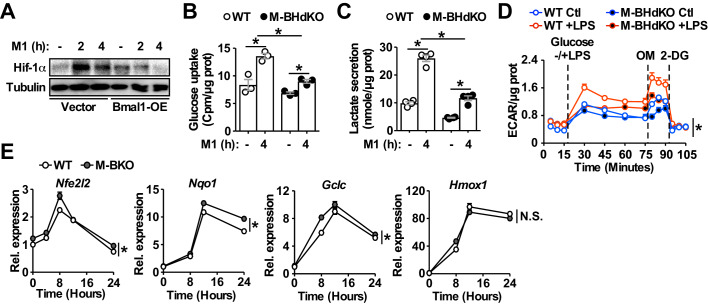
Increased oxidative stress and Hif-1α activity in M1 activated M-BKO macrophages.(A) Hif-1α protein levels in M1-activated (primed with 10 ng/mL Ifn-γ and stimulated with 50 ng/mL LPS) control and Bmal1-OE RAW264.7 stable lines. (B, C) Uptake of [3H]−2-deoxyglucose and lactate secretion in control or M1-activated macrophages. N = 3 biological replicates, statistical analysis was performed using Student’s T test. M-BHdko: myeloid-specific Bmal1 and Hif1a double knockout. (D) Glycolytic stress test in Ifn-γ-primed macrophages measuring ECAR following glucose (25 mM) injection without or with LPS (100 ng/mL). Maximal glycolytic rate was determined by injection of oligomycin (OM, 2 μM), and glycolysis-dependent ECAR was determined by injection of 2-deoxyglucose (2-DG, 50 mM). The assay medium contained minimal DMEM with 2% dialyzed FBS, pH 7.4. N = 5 biological replicates. The difference between LPS-treated WT and M-BHdKO macrophages was determined by two-way ANOVA across the time course. (E) Expression of Nrf2 target genes determined by qPCR throughout a 24-hr time course following M1 stimulation. N = 3 biological replicates, statistical analysis was performed using two-way ANOVA for WT vs M-BKO across the time course. Data are presented as mean ± S.E.M. *, p<0.05. Experiments were repeated at least twice.